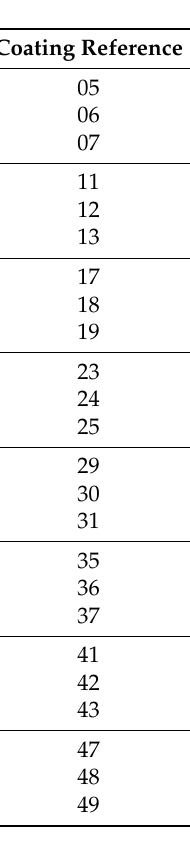
Table 2. Description of the 24 coatings. PVC: pigment volume